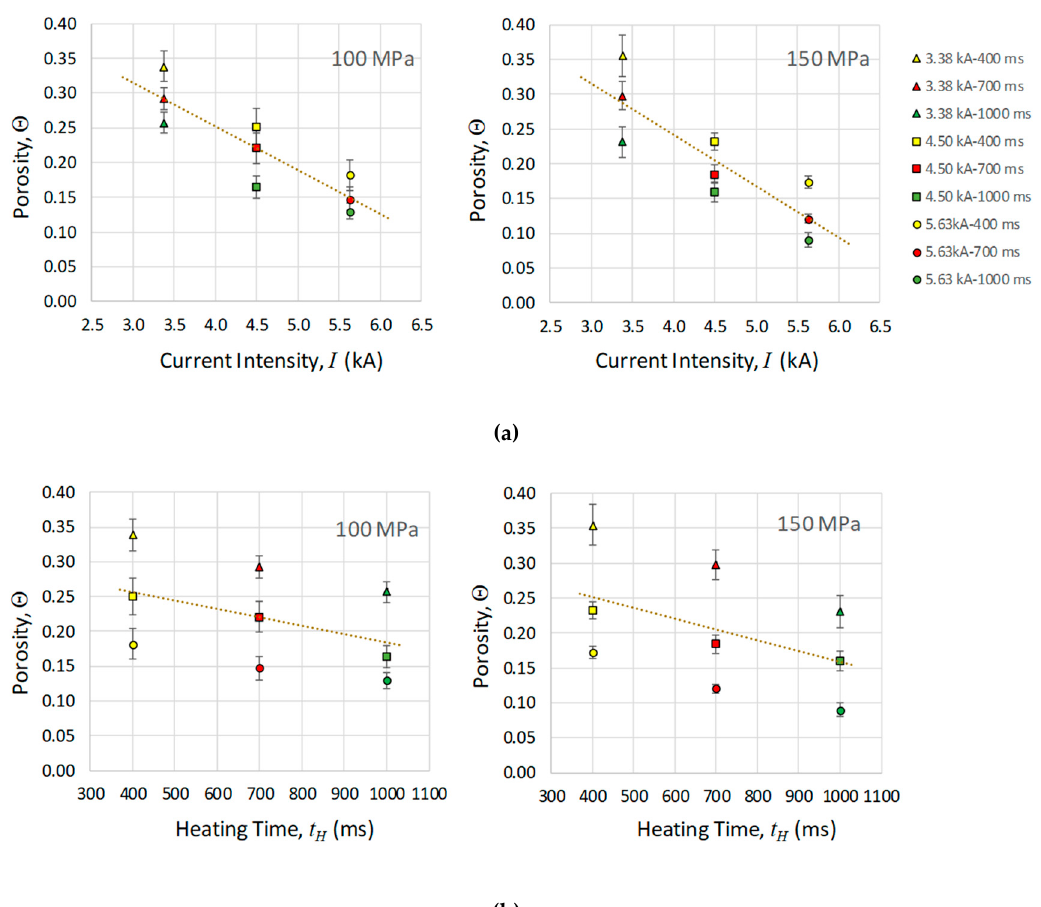
Figure 5. Porosity of 9 mm in diameter compacts ( Θ ) represented versus: ( a ) Current intensity and ( b ) heating time, for the di ff erent MF-ERS experiments with two pressures (100 and 150 MPa). The dotted lines in the graphs represent the trend of the whole set of points.